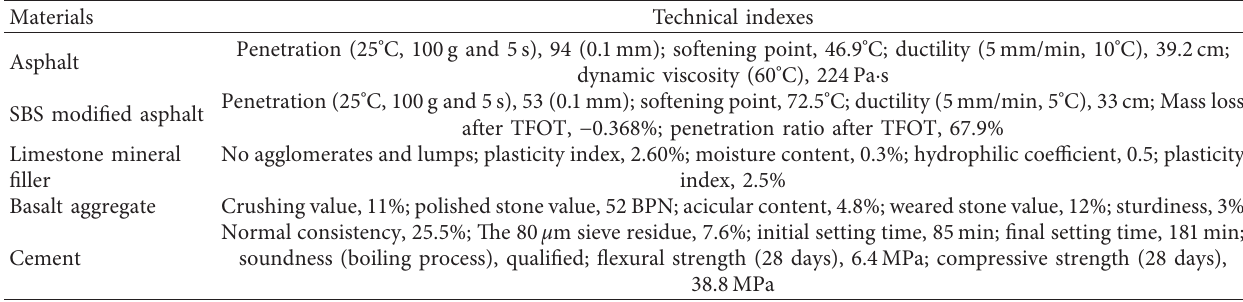
Table 1: The main technical indexes of asphalt and mineral materials.